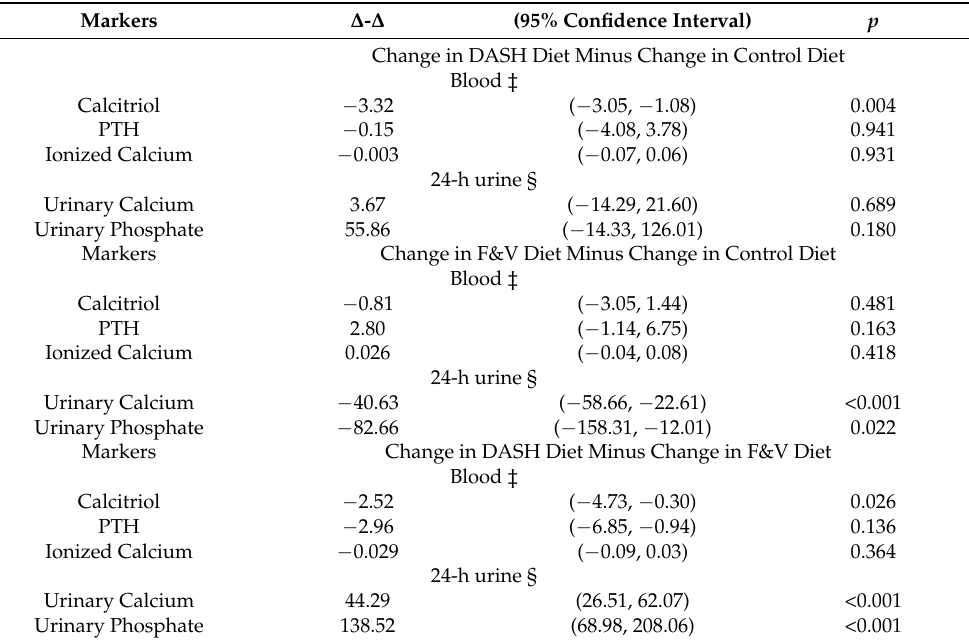
Table 3. Comparisons of mean changes in calcitriol, PTH, ionized calcium, urinary calcium & urinary phosphorus between diets in all